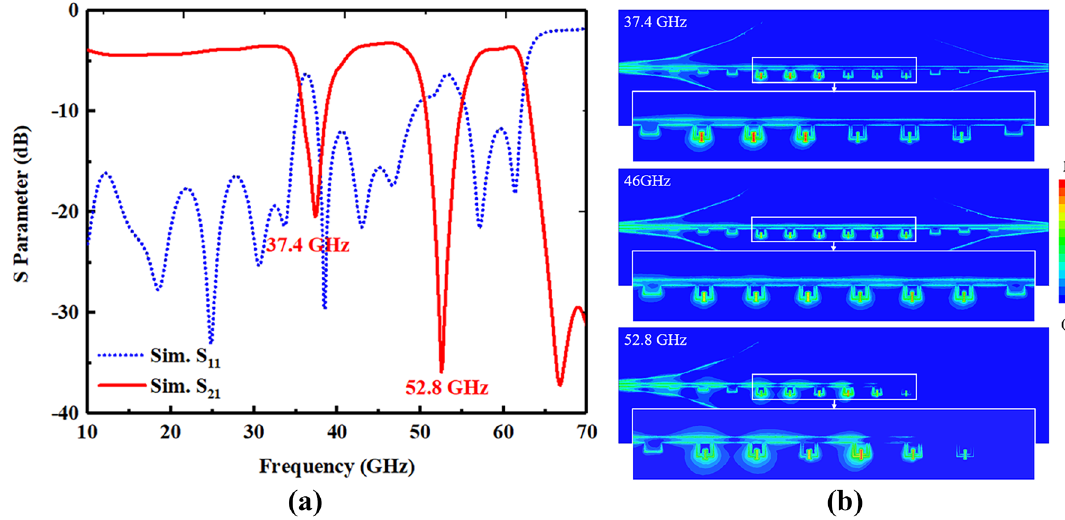
Figure 3. ( a ) Simulated S-parameters of the passive spoof SPP device. ( b ) E-field distribution of the